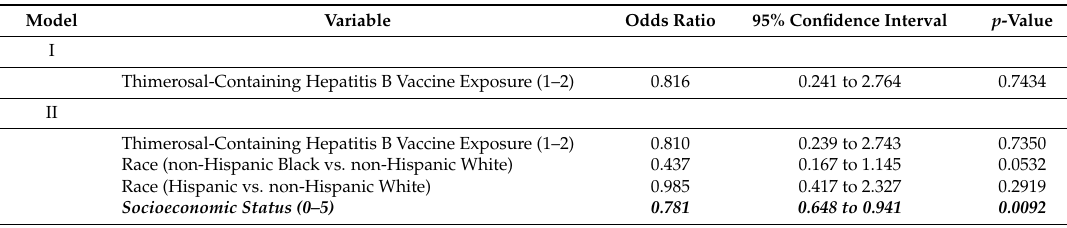
Table 4. A summary of survey logistic regression models 1 generated to examine the potential relationship between infant hepatitis B vaccine exposure and the risk of having a stomach or intestinal illness within the last 30